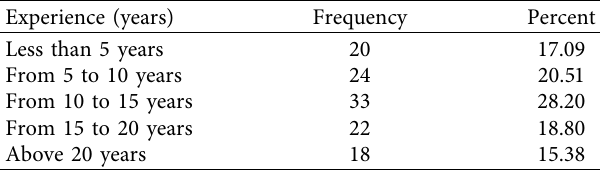
Table 1: Respondents’ Work Experience in the industry.